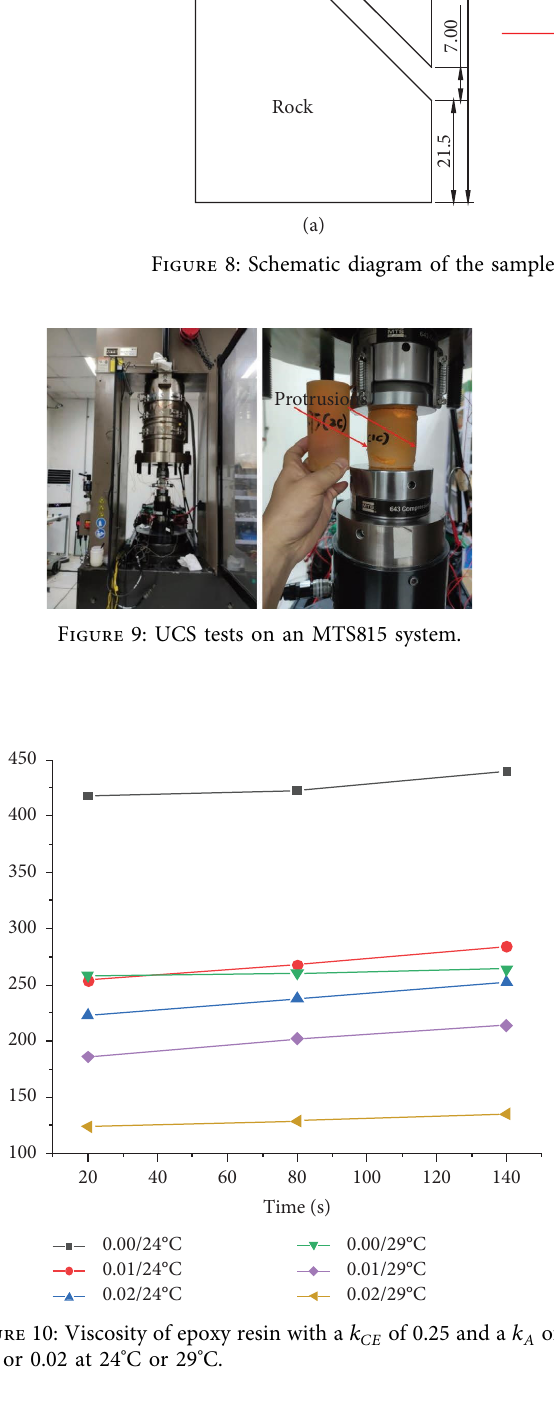
k CE of 0.25 and a A of